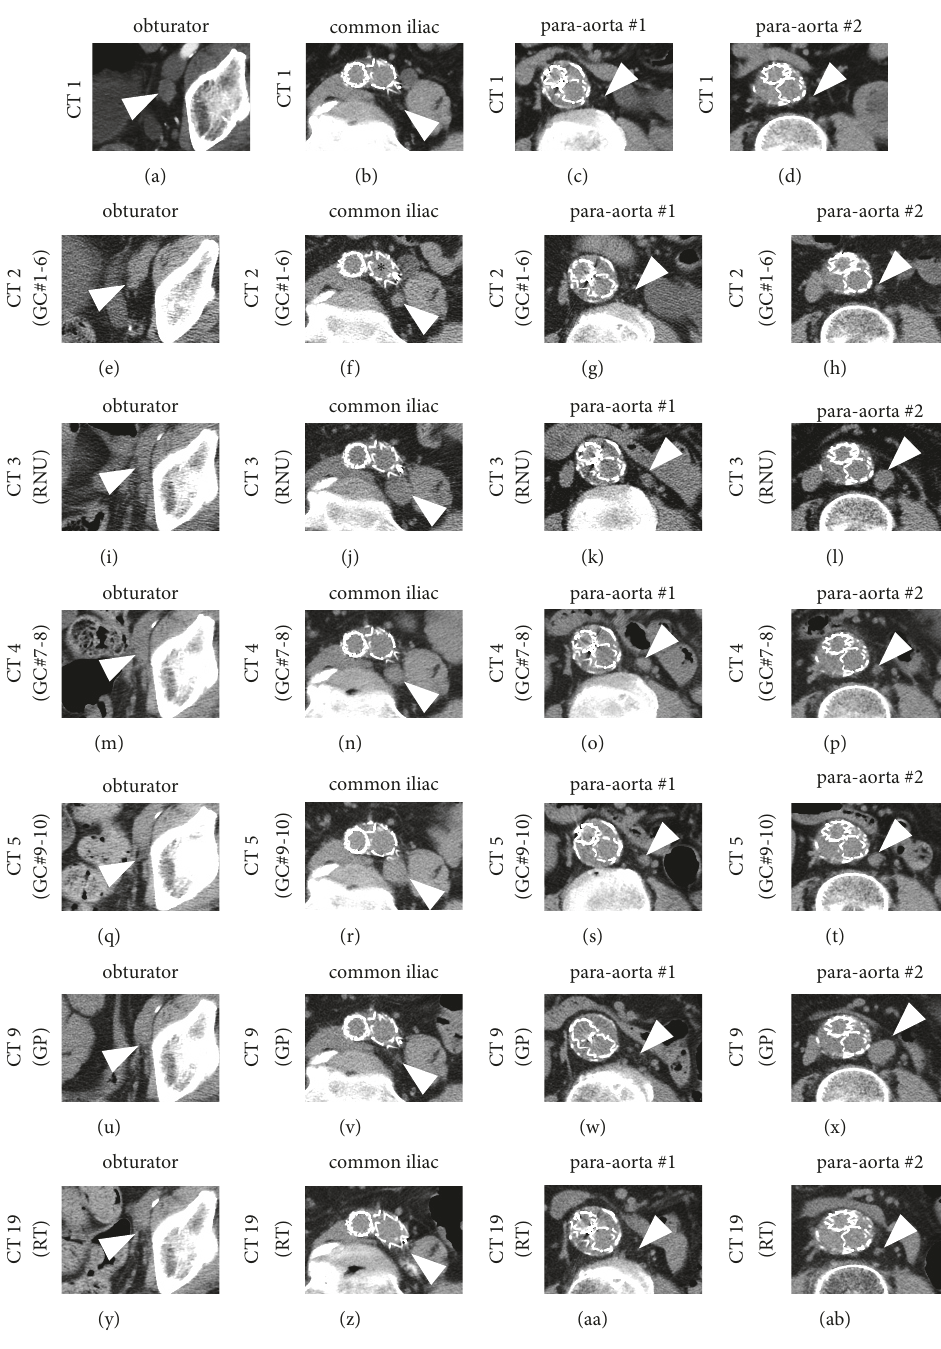
Figure 1: Selected CT images of the lymph nodes for every treatment modality . (a–d), (e–h), (i–l), (m–p), (q–t), (u–x), and (y–ab) represent CT scans #1, #2, #3, #4, #5, #9, and #19 in supplemental Figure 1, respectively. Arrowheads in the 1st to 4th columns show the obturator lymph nodes, common iliac lymph nodes, para-aortic lymph node #1, and para-aortic lymph node #2, respectively. CT: computed tomography, GC: chemotherapy using gemcitabine and cisplatin, RNU: radical nephroureterectomy, GP: chemotherapy using gemcitabine and paclitaxel, and RT: